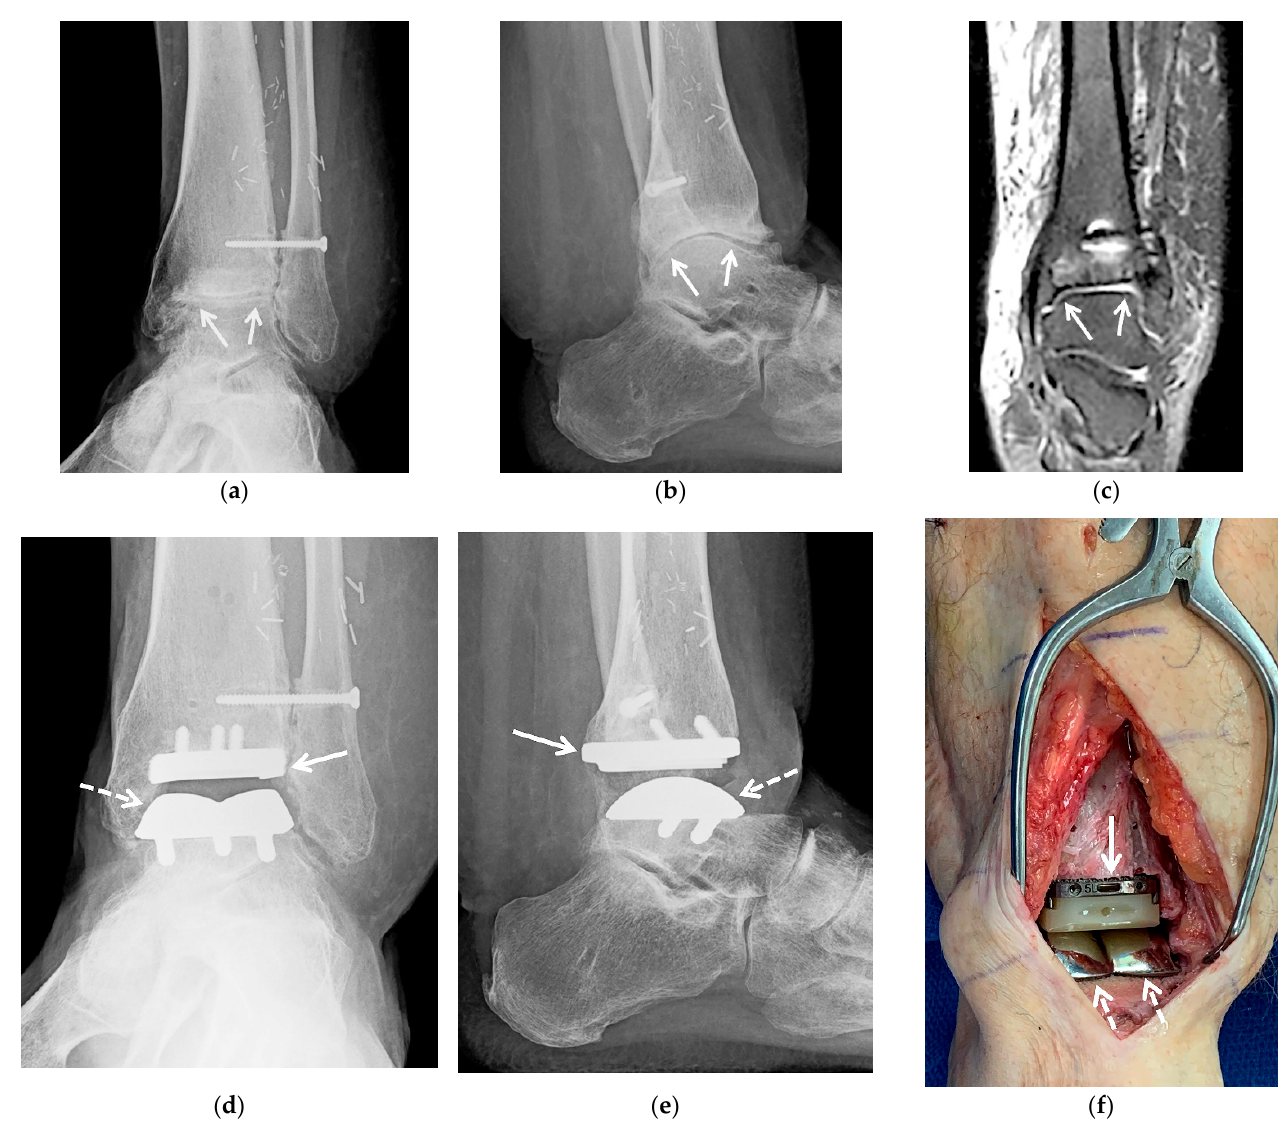
Figure 8. ( a – f ) A 36-year-old male with posttraumatic osteoarthritis of the left tibiotalar joint and equinus contracture resulting from open distal tibia fracture treated with open reduction internal fixation and free flap, with previous hardware removal, subsequently treated with ankle arthroplasty and gastrocnemius resection. ( a ) Mortise and ( b ) lateral weight-bearing radiographs of the left ankle show marked asymmetric narrowing of the tibiotalar joint (white arrows) with marginal osteophytes and intraarticular bodies consistent with severe osteoarthritis. Note tracts in the calcaneus and talus related to removed surgical hardware and retained laterally placed screw transfixing the distal tibiofibular syndesmosis. Numerous vascular clips overly the soft tissues of the lower leg. ( c ) Coronal fluid sensitive MR image shows asymmetric narrowing of the tibiotalar joint (white arrows). ( d ) Mortise and ( e ) lateral postoperative radiographs show interval placement of total ankle arthroplasty (Wright Medical Infinity with an Inbone talus). Note well seated tibial (white arrow) and talar (dashed white arrow) prosthesis components. ( f ) The intraoperative image shows tibial (white arrow) and talar components (dashed white arrow) in place.